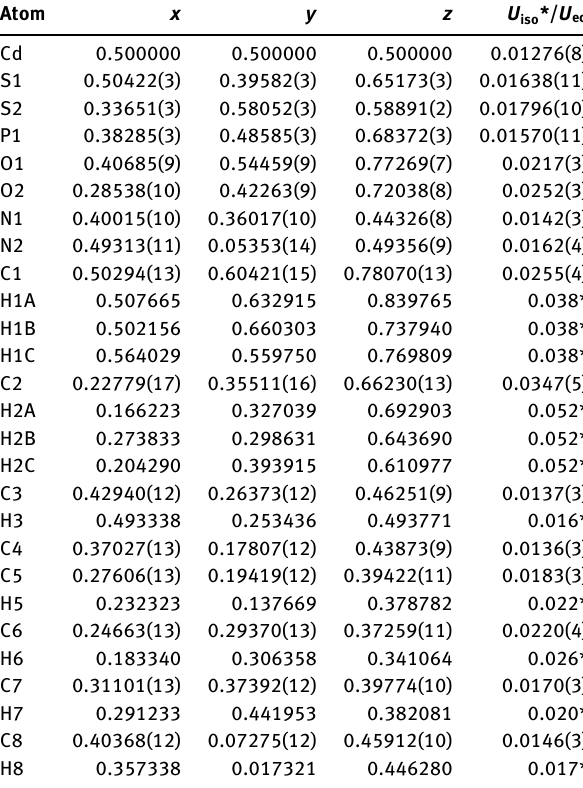
Table 2: Fractional atomic coordinates and isotropic or equivalent isotropic displacement parameters (Å 2